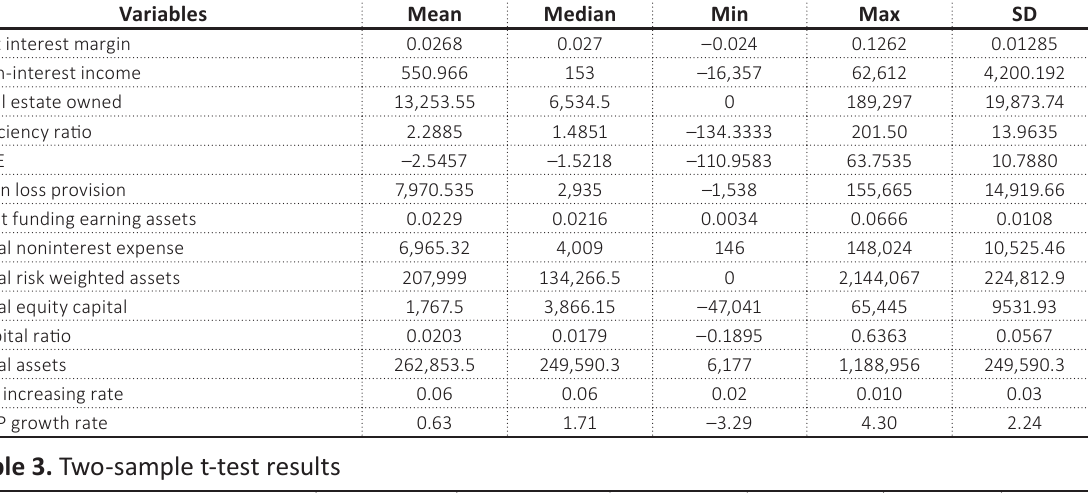
Table 2. Descriptive statistics 2001–2014